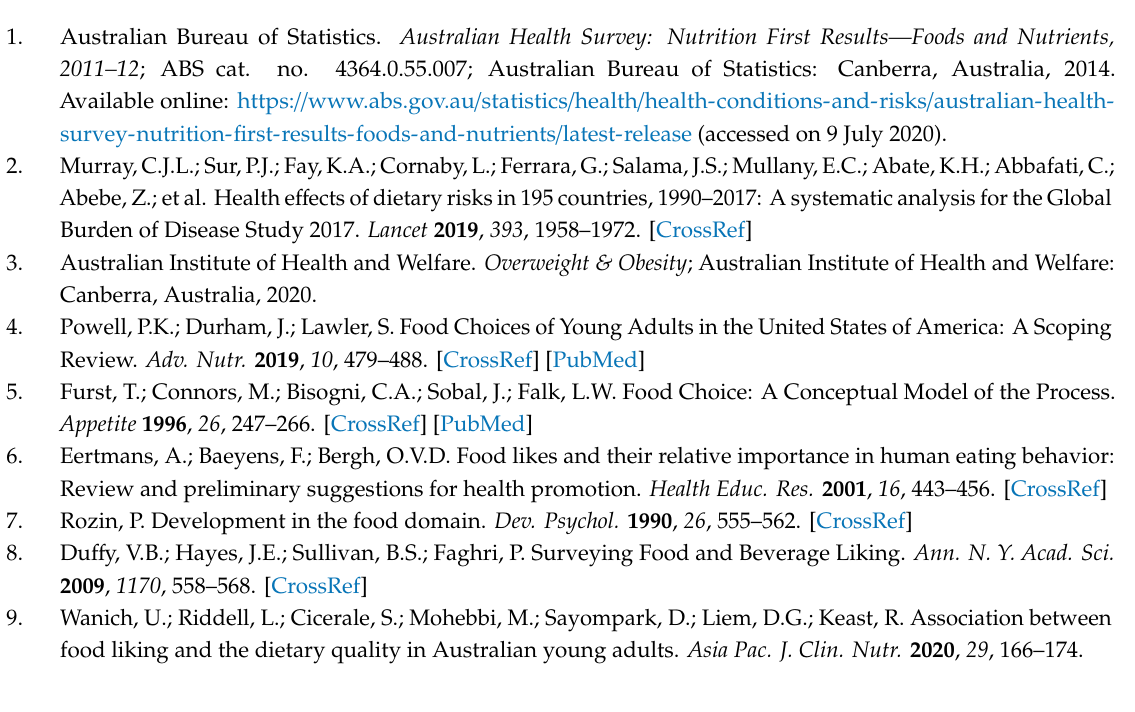
Table S1: Food liking groups created from the Food Liking Questionnaire; Table S2: Correlations between food liking